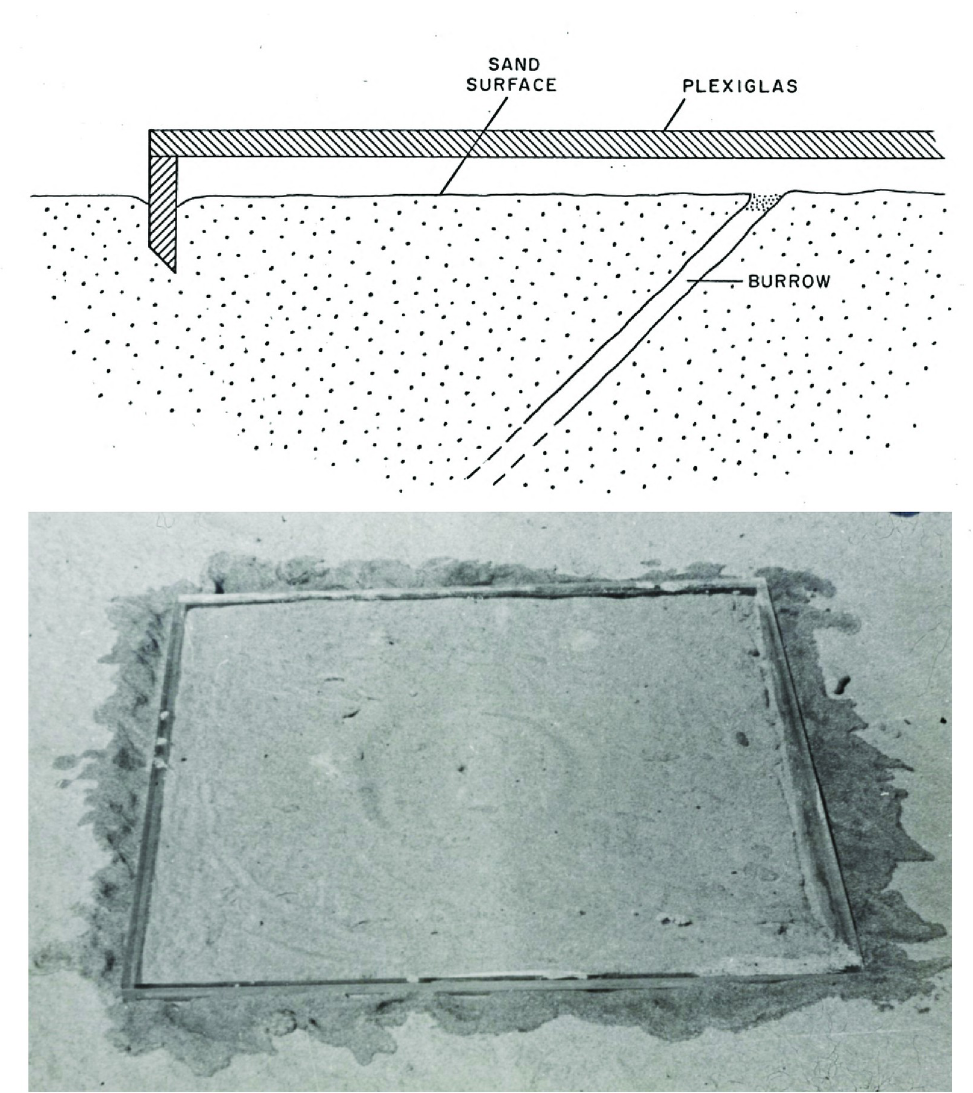
Fig 3. Excluding all possible local cues to burrow location except local visual cues. A large, clear plexiglass frame was placed over a burrow with vertical side-walls pushed into the sand without disturbing the local sand relief around the burrow. All returning wasps searched for the burrow entrance at the center of this